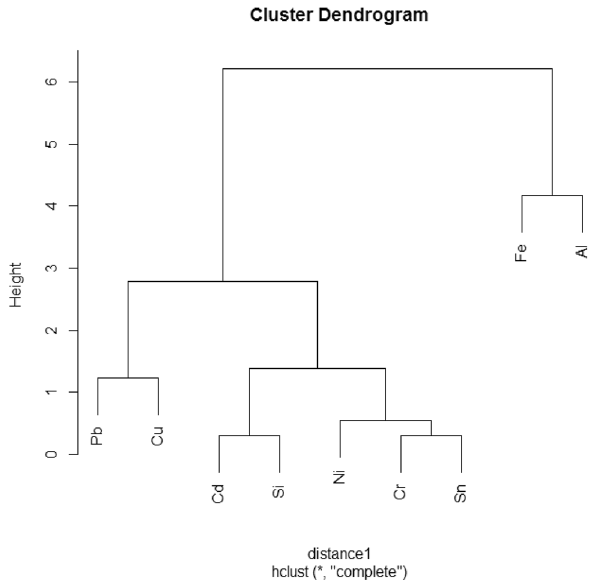
Fig. 9 Dendrogram for heavy metals in Lagos lagoon